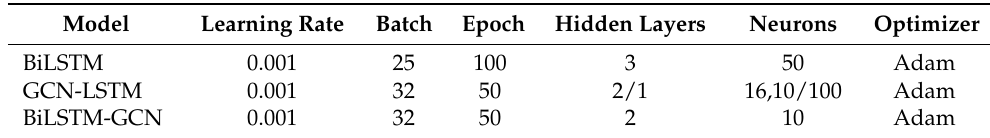
Table 2. Selected parameters for the combined model proposed in this work and the DNN models implemented for comparative